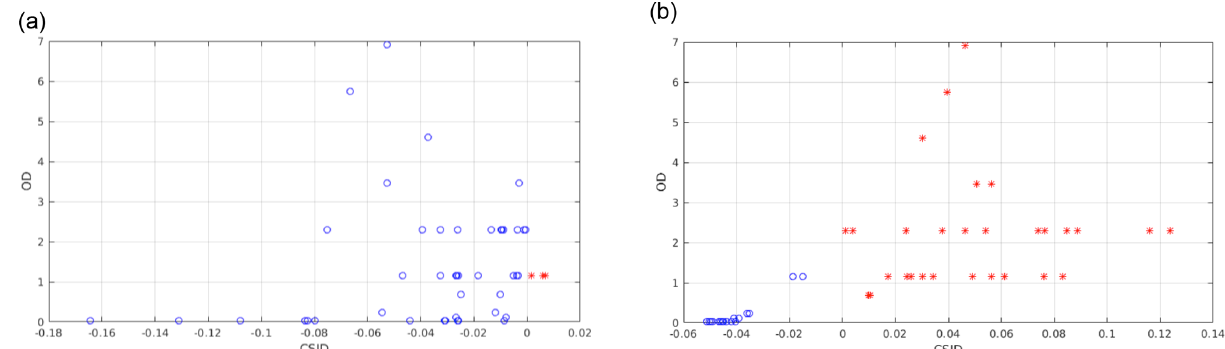
Figure 14. Correctly classified (red asterisks) and misclassified (blue circles) cloudy-sky spectra from the polar summer (POLSUM) test set. Data are plotted as a function of the corrected similarity index difference (CSID) and cloud optical depth (OD), and the distributional approach is considered. In panel (a) only the MIR features are accounted for while in panel (b) the full spectrum is exploited in the classification.